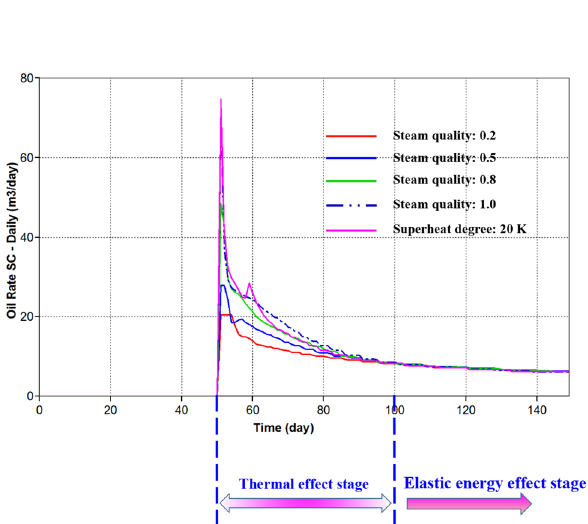
Fig. 9 Daily oil production rate under different steam state